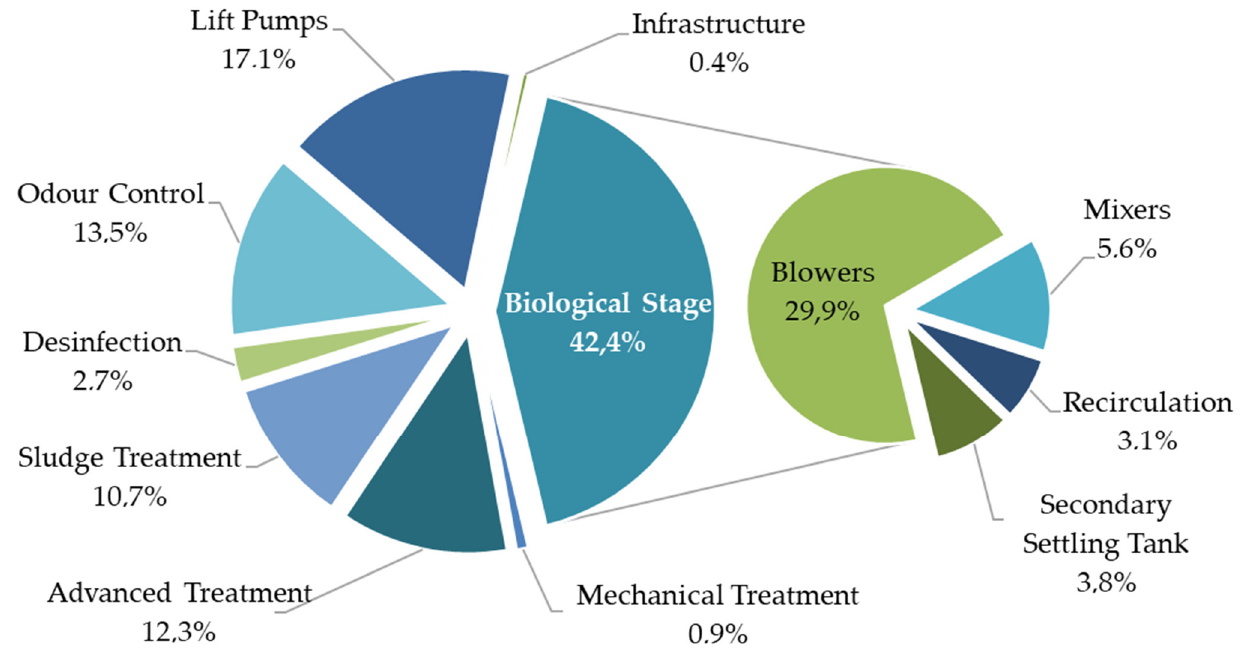
Figure 5. Energy consumption distribution in the example WWTP.